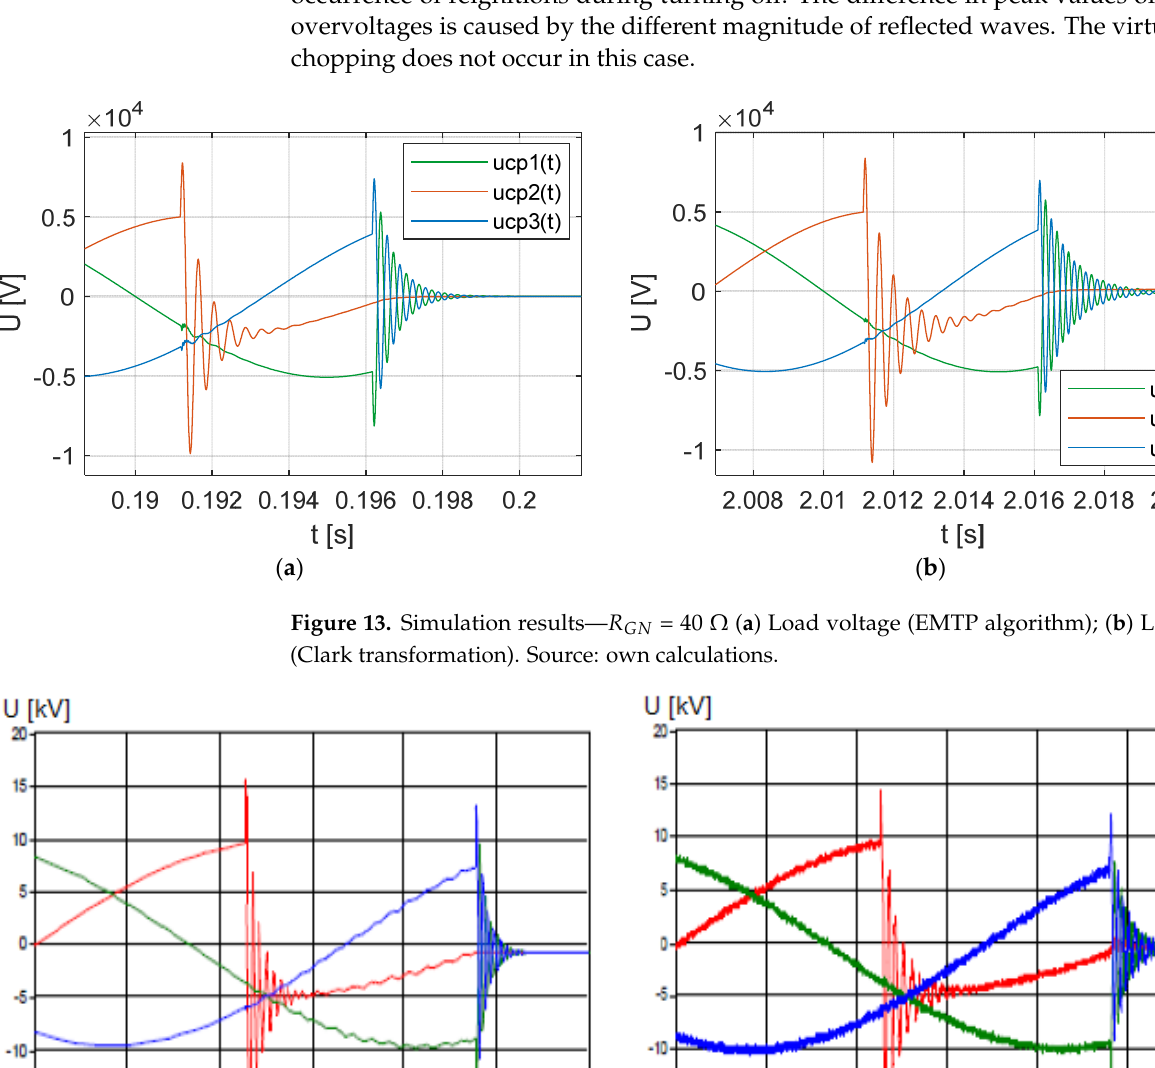
Figure 12. Simulation results— 𝑅 (cid:3008)(cid:3015) = 100 MΩ ( a ) Load voltage (EMTP algorithm); ( b ) Load voltage (Clark transformation). Source: own calculations.